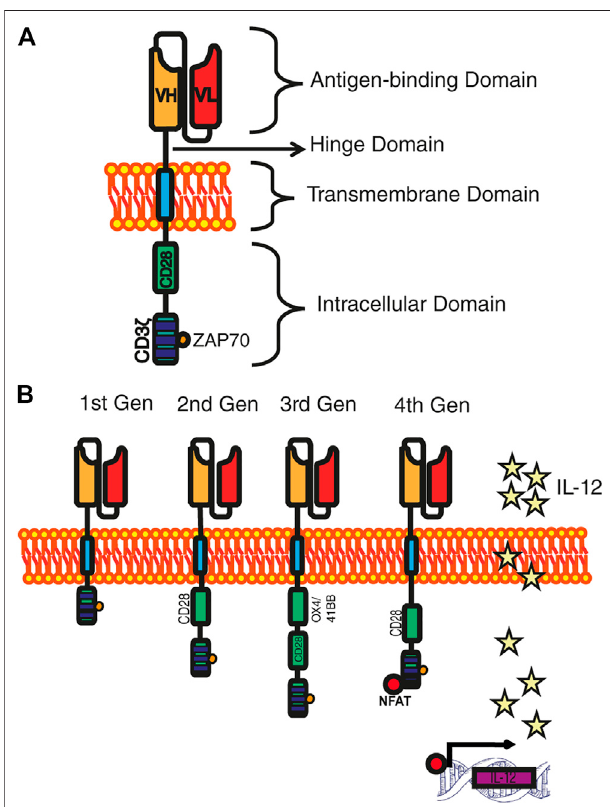
FIGURE 1 | Development of CAR generations. (A) Archetype of a CAR. The four main domains that make up a CAR are distinguished: the recognition domain, the hinge domain, the transmembrane domain, and the intracellular domain. (B) CARs generations. First-generation CARs only own the CD3 ζ in the intracellular domain; the second-generation CARs incorporate a costimulatory domain; the third-generation CARs include two costimulatory domains;andfourth-generationCARsarereinforcedwithgenesthatallowthe expression of cytokines.